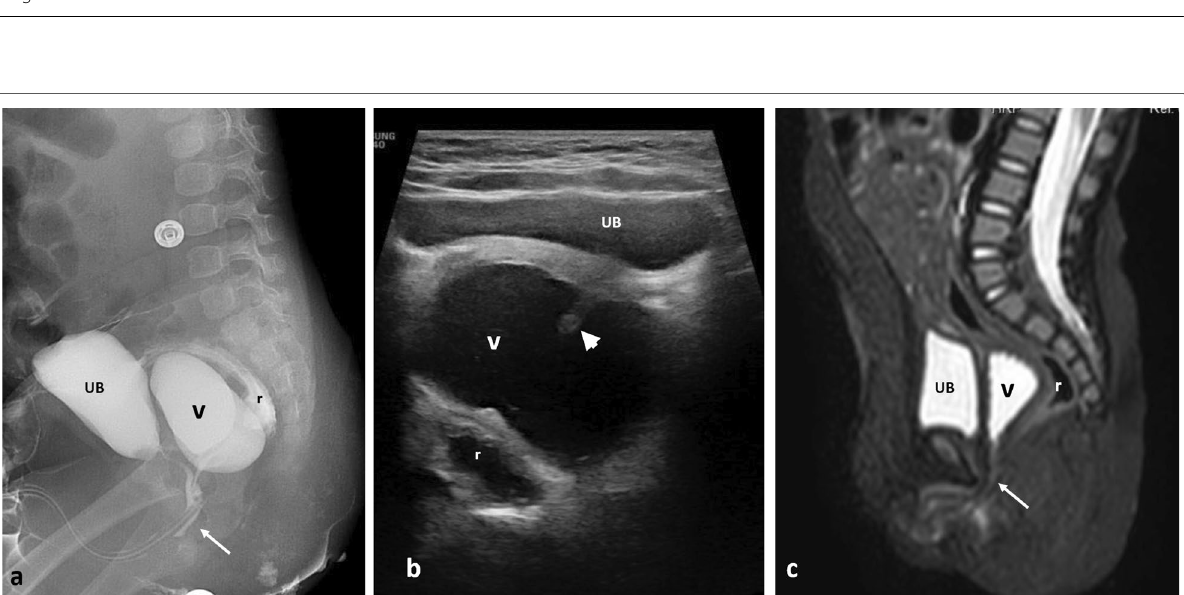
Fig. 17 Imaging of congenital adrenal hyperplasia a ultrasound showing enlarged suprarenal gland having cerebriform pattern (asterisk); b , c genitography and sagittal T2WI MRI showing confluence of the distended vagina and urinary bladder into the common urogenital sinus (arrow). V vagina